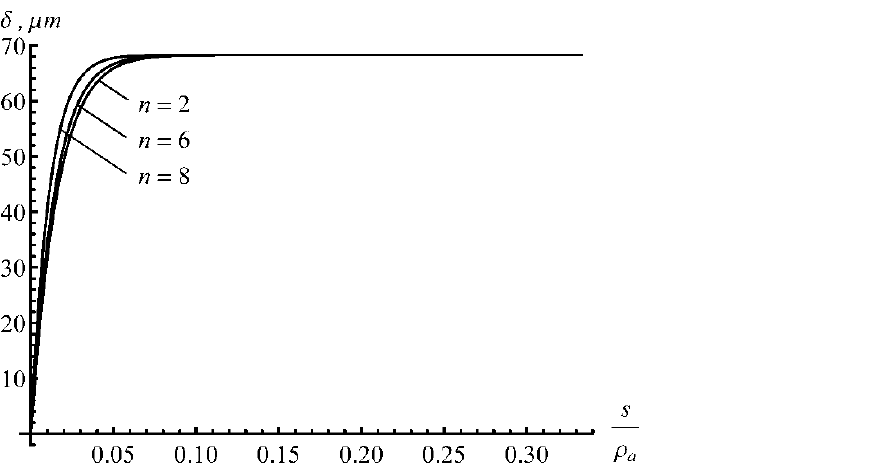
Figure 6. Thickness of the layer of intensive plastic deformation along the friction surface at θ 0 = 30 o and different n − values.